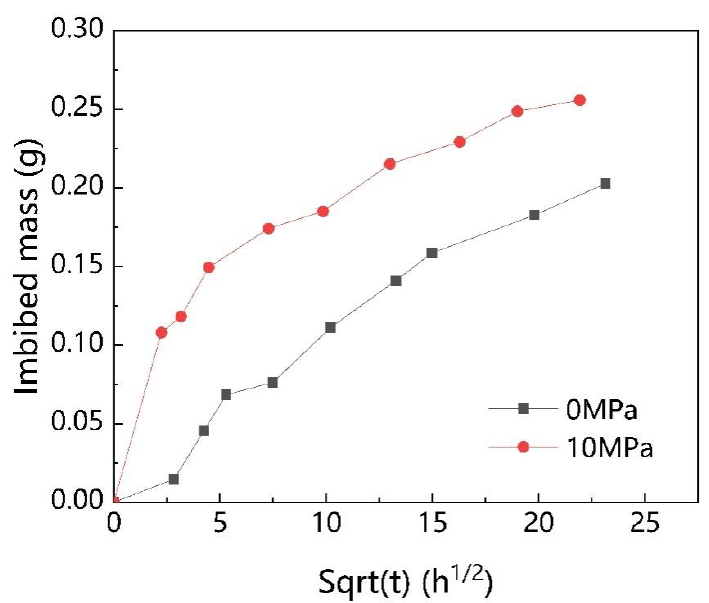
Figure 13. Development of imbibition mass of sample YSS under 1 atm and 10 MPa.